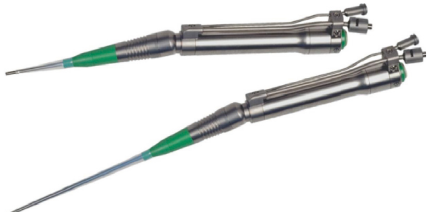
Figure 4: Example of handpieces and